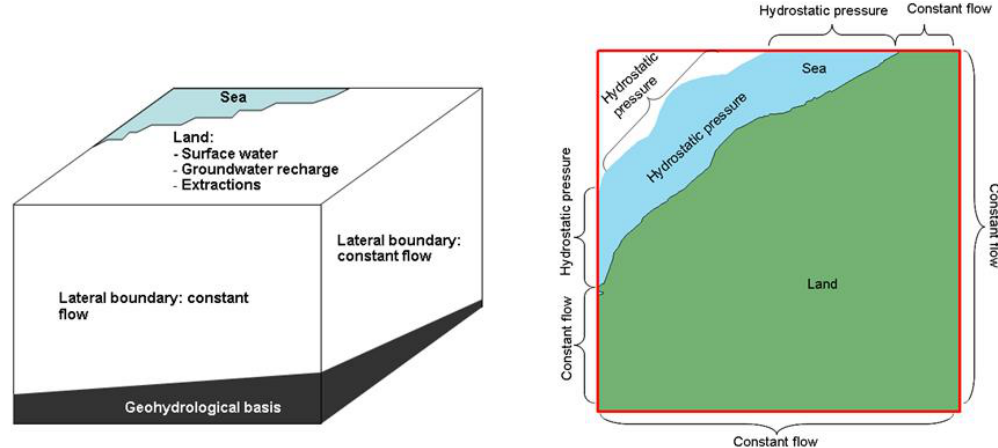
Figure 7 3-D view (left) and top view (right) showing the model boundaries. Fig. 7. 3-D view (left panel) and top view (right panel) showing the model boundaries. where β C is the volumetric concentration expansion gradient (m 3 kg − 1 ), in this case 1.34 × 10 − 6 l mg − 1 Cl − . The concentration used for the constant flow boundaries is the one introduced as initial 3-D chloride field in the model (see Sect.